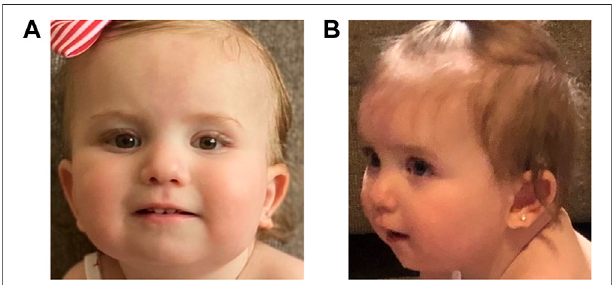
FIGURE 1 | Pictures of the proband showing mild dysmorphic features. In both pictures, the proband is slightly tilting her head up; panel (A) : an epicanthalfoldisnoted ontheright. Ontheleft,mild microphthalmosisnoted. Her ears are standard set with posterior rotation; panel (B) : her left ear lobe is notched. The proband has a thin upper